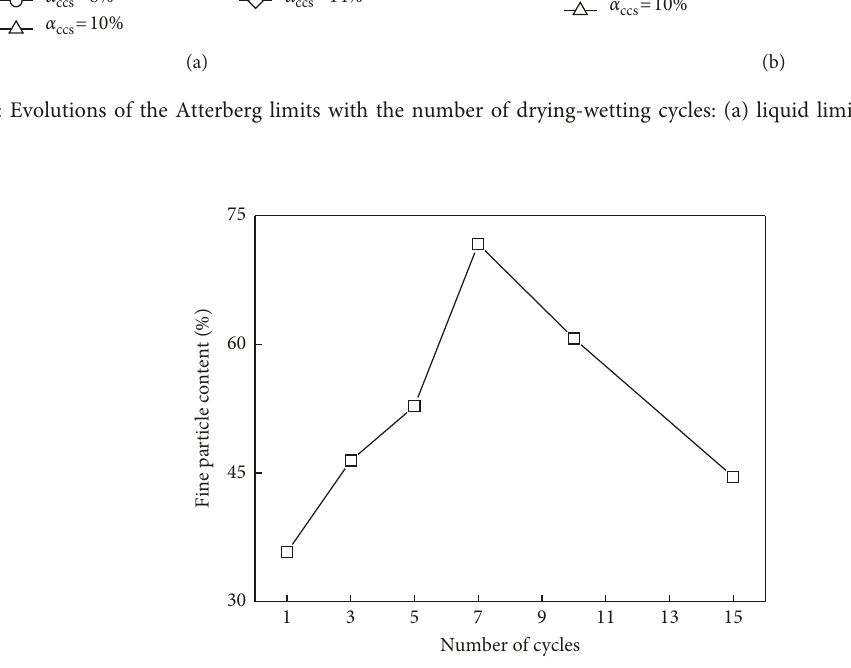
Figure 11: Relationships between of the fine particle content and the number of drying-wetting cycles. Table 5: Atterberg limits of the tested specimen.